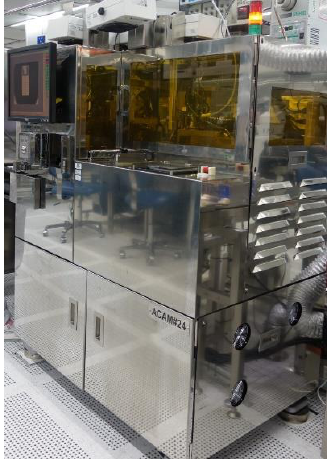
Fig . 1 Auto Core Adhesion Mounting machine